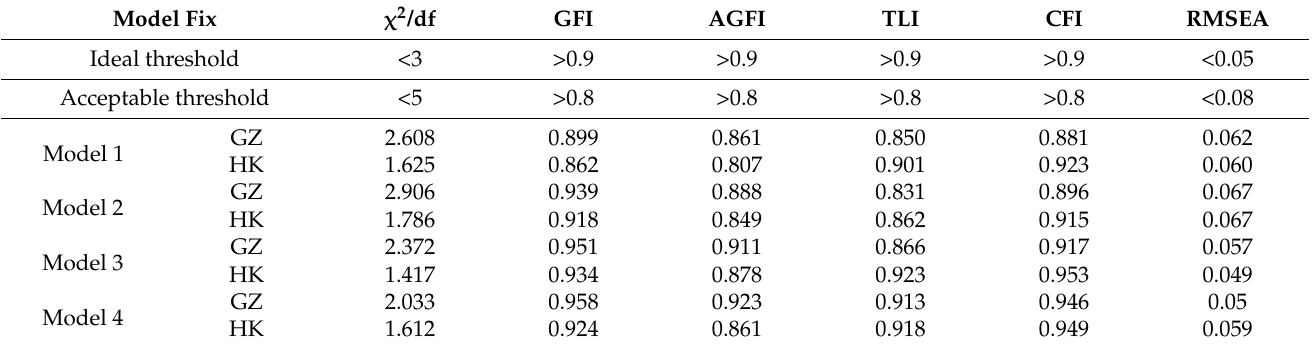
Table 3. Model fit indices of model